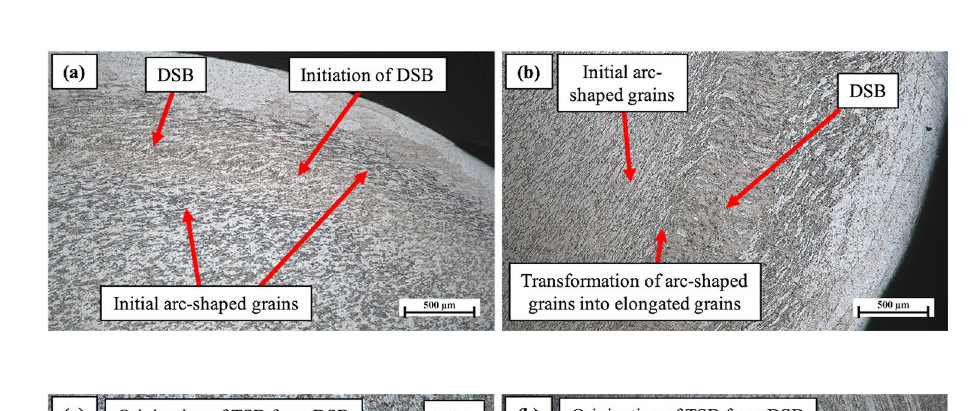
Fig. 10 OM images show- ing the origination of TSB from DSB in the specimens deformed with ( a ) 4300 s −1 at 300 °C and ( b ) 5000 s −1 at 300